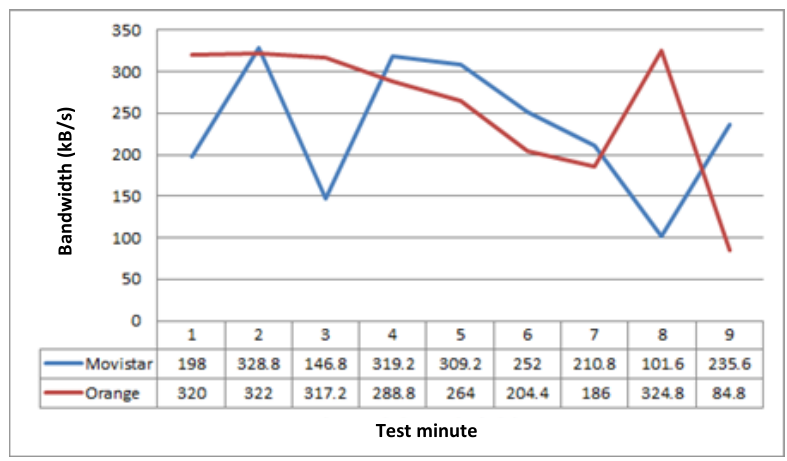
Figure 3. Estimated bandwidth mean